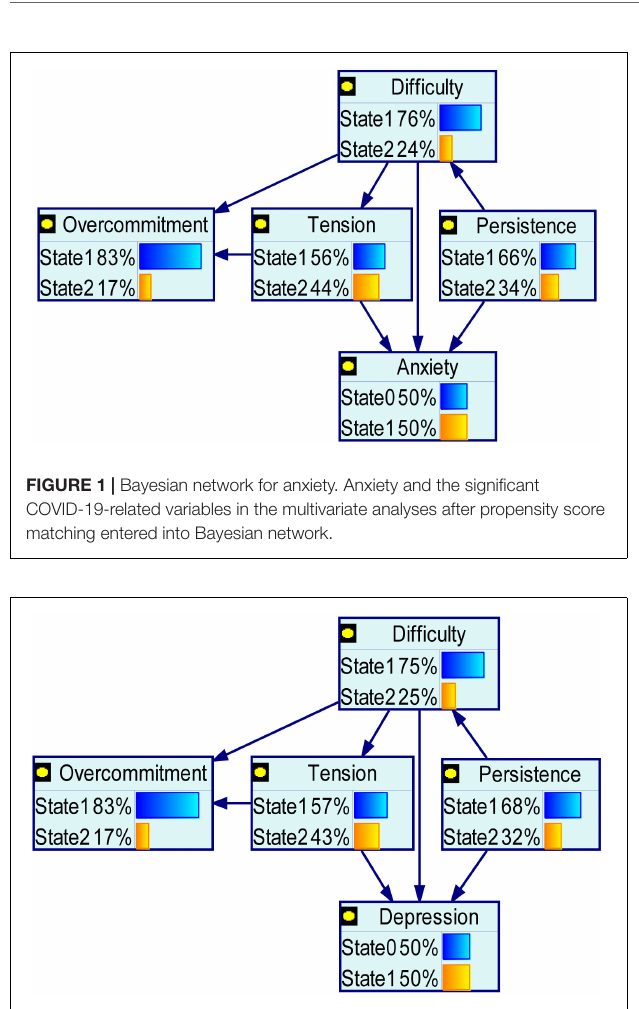
FIGURE 2 | Bayesian network for depression. Depression and the significant COVID-19-related variables in the multivariate analyses after propensity score matching entered into Bayesian network.